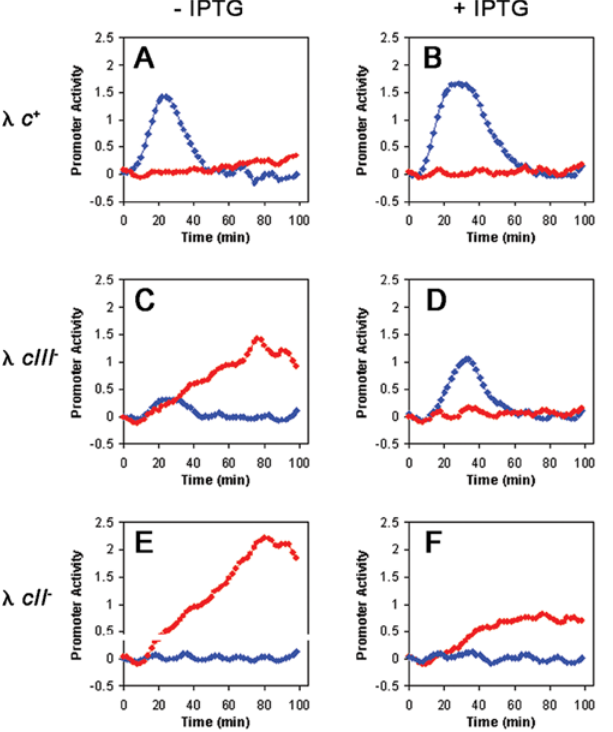
Figure 6. CIII levels effect on CII and Q activity invivo. CII activity is reported by pE- gfp fusions (blue diamonds), whereas Q activity is reported by pR‘-tR‘- gfp fusions (red circles). Promoter activity is given as a function of time of infected cultures carrying the pCTCIII plasmid in the presence or absence of 0.1mM IPTG ( B, D, F or A, C, E respectively) with l c + ( A, B ), l cIII 2 ( C, D ), and l cII 2 ( E, F ). All measurements were carried out as described in the materials and methods at a MOI of 6.